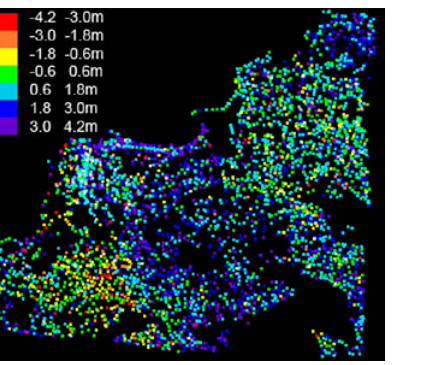
Figure 2. Color coded height differences ZY3 DSM, based on affine bias correction, against reference DSM from IGN